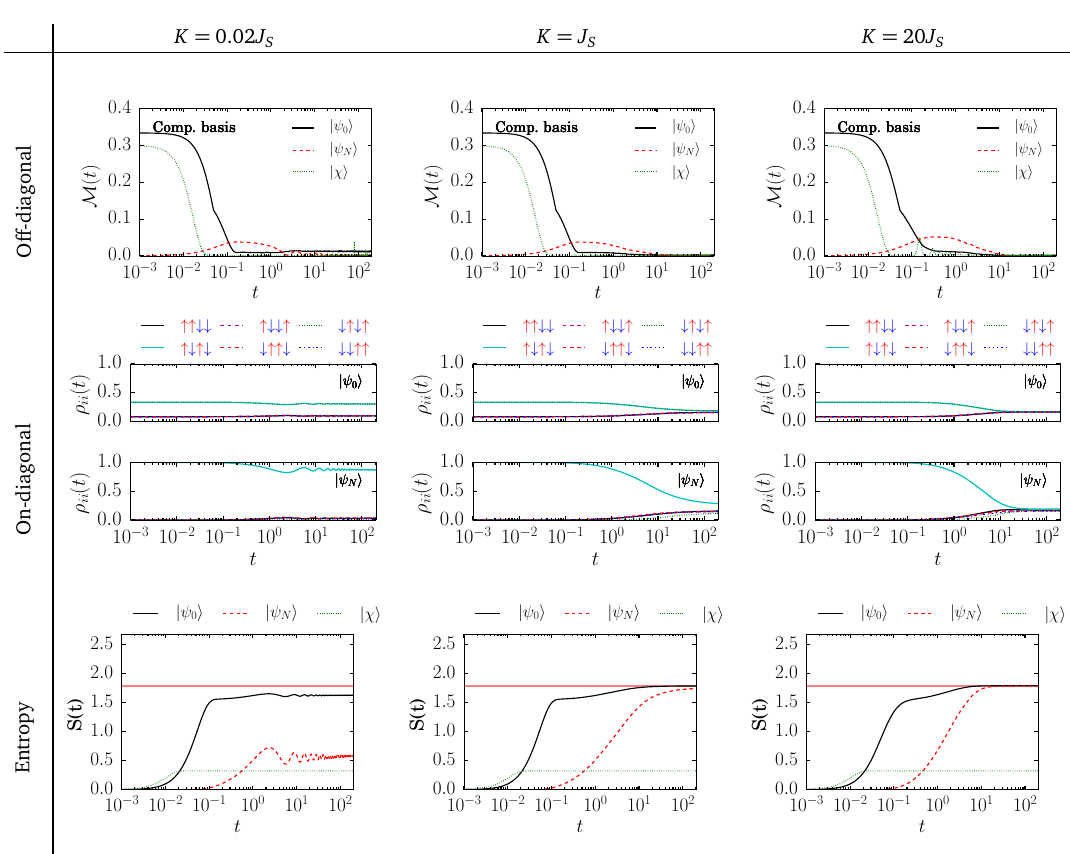
( t ) , expressed in the computational Figure 2: Time-evolution of the reduced density matrix ρ ij basis, for different intra-environment strengths, K , (columns) and initial states of the central- (cid:112) 〉 , Néel-state | ψ 〉 = |↑↓↑↓〉 , and | χ 〉 = [ |⇑〉 + 3 |⇓〉 ] / system (to wit, ground state | ψ 10). The N 0 = 4 spins that are connected to each of the N = 16 environment central-system consists of N (cid:69) S spins via random antiferromagnetic Ising coupling of strength I = 20 J . The top row indicates S the maximum off-diagonal components (cid:77) ( t ) [ Eq. (18) ] as function of dimensionless time t . = 0 subspace, as indicated The middle row depicts the diagonal components of ρ ( t ) in the S z tot by the spin configurations in the legend. The von Neumann entropy of ρ ( t ) is shown in the bottom row, and the red horizontal line indicates the maximal entropy that can be attained = 0 subspace. Time t has been made dimensionless in units of J in the S z and ħ h , i.e. S tot / ħ h ≡ t t (cid:48) → t (cid:48) J S